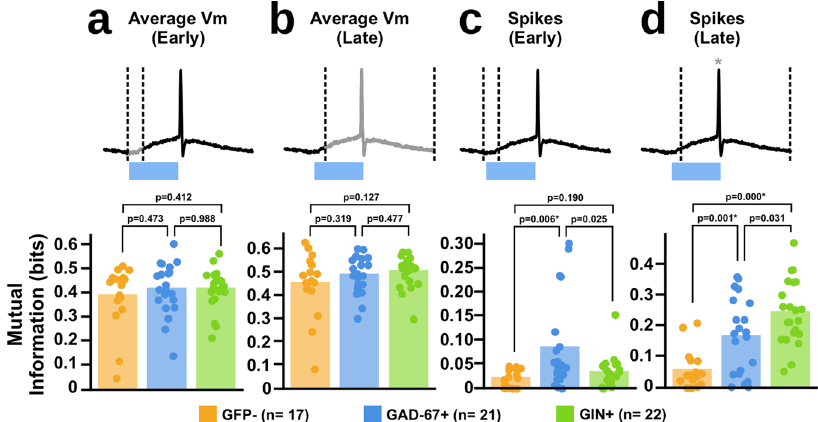
Fig. 5 Different subtypes of interneurons carry different amounts of information in response to our synchrony encoding. a Mutual information analysis of the average membrane potential of each cell type to our 1-bit signal within early (0 – 5 ms) response. Dotted lines indicate window of analysis, with greyed areas indicating what part of the response was analysed (One-way ANOVA, F(2,57) = 0.432, p = 0.656; post-hoc t -tests: GFP − vs. GIN + : t(35) = − 0.830, p = 0.412; GAD67 + vs. GIN + : t(41) = − 0.00, p = 0.988; GFP − vs. GAD67 + : t(36) = − 0.737, p = 0.473, * = tests signi fi cant at p ≤ 0.017 with Bonferroni correction). b Same analysis as ( a ) but restricting the analysis to only the later (5 – 50 ms) responses (One-way ANOVA, F(2,57) = 1.40, p = 0.244; post hoc t -tests: GFP − vs. GIN + : t(37) = − 1.56, p = 0.127; GAD67 + vs. GIN + : t(41) = − 0.809, p = 0.477; GFP − vs. GAD67 + : t(36) = − 0.933, p = 0.319; * = tests signi fi cant at p ≤ 0.017 with Bonferroni correction). c Mutual information analysis of the spike counts of each cell type to our 1-bit signal within early (0 – 5 ms) response (Kruskal – Wallis, H(2) = 9.88, p = 0.007; post-hoc t -tests: GFP − vs. GIN + : t(37) = − 1.35, p = 0.190; GAD67 + vs. GIN + : t (41) = 2.37, p = 0.025; GFP − vs. GAD67 + : t(36) = − 3.01, p = 0.006*, * = tests signi fi cant at p ≤ 0.017 with Bonferroni correction). d Same analysis as ( c ) but restricting the analysis to only the later (5 – 50 ms) responses (Kruskal – Wallis, H(2) = 21.2, p ≤ 0.001; post-hoc t -tests: GFP − vs. GIN + : t(37) = − 6.94, p ≤ 0.001*; GAD67 + vs. GIN + : t(41) = − 2.26, p = 0.031; GFP − vs. GAD67 + : t(36) = − 3.49, p = 0.001*, * = tests signi fi cant at p ≤ 0.017 with Bonferroni